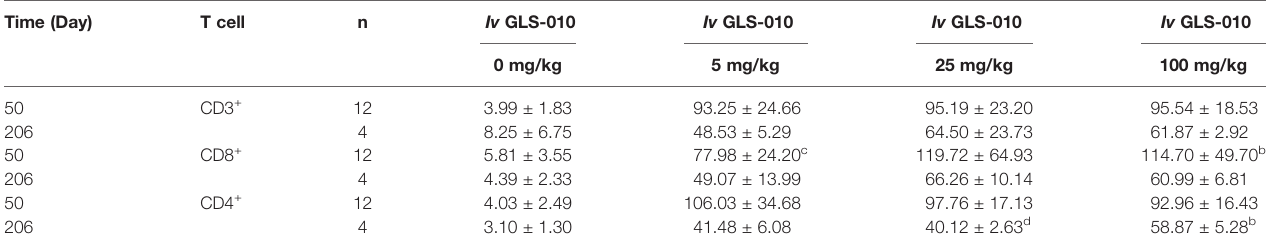
TABLE 3 | The average RO rate of CD3 + ,CD4 + , and CD8 + T cells in monkeys following Iv of GLS-010 at different doses (%, Mean ± SD).